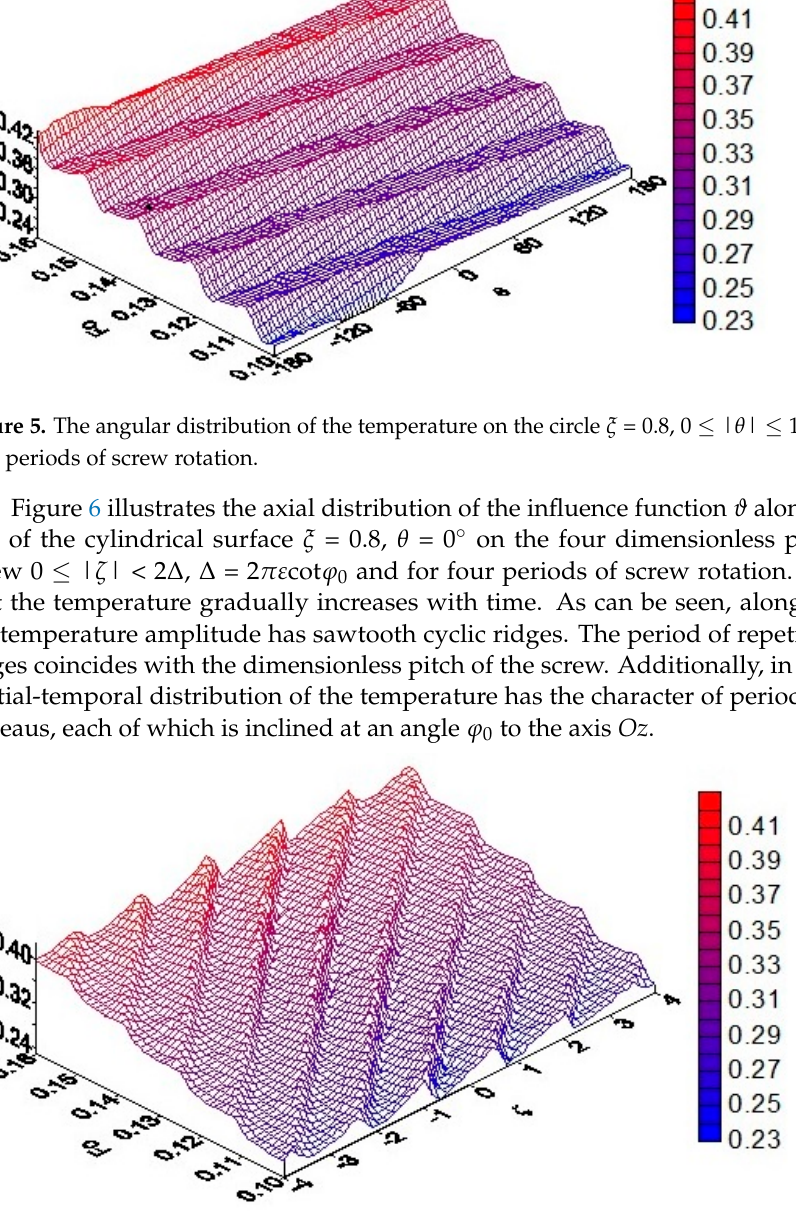
Figure 7. The 3-D radial-angular instantaneous distribution of function ϑ in the cross-section ζ = 0.5. A completely different instantaneous temperature distribution is observed in the plane of the longitudinal section of the channel θ = 0° (Figure 8). Here, the calculations are performed within four dimensionless screw steps 0 ≤ | ζ | ≤ 4 at Fo = 0.5. The temperature field here is highly heterogeneous. The frequent oscillation in the amplitude of the func- tion ϑ is associated with a change in the phase of the temperature fluctuations during rotation of the screw.